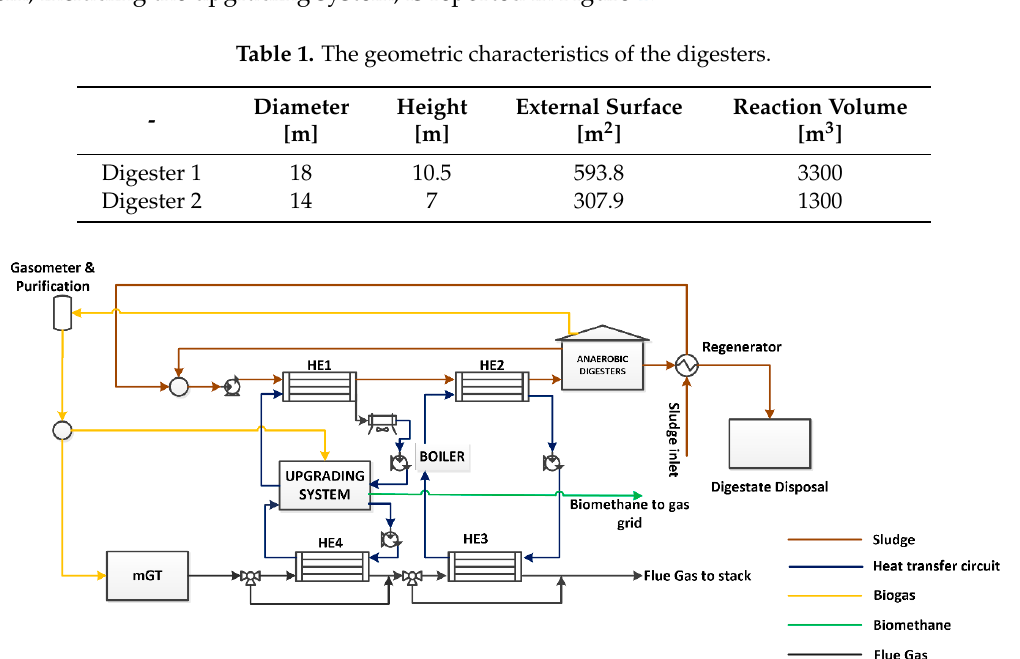
Table 1. The geometric characteristics of the digesters.